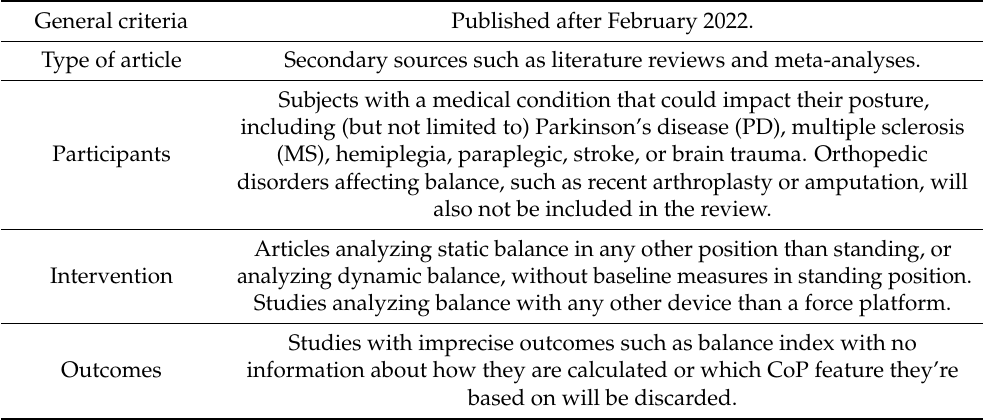
Table 3. Exclusion